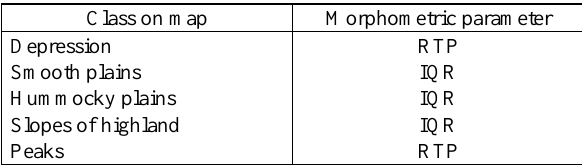
Table 1. Preferred morphometric parameters for relief forms